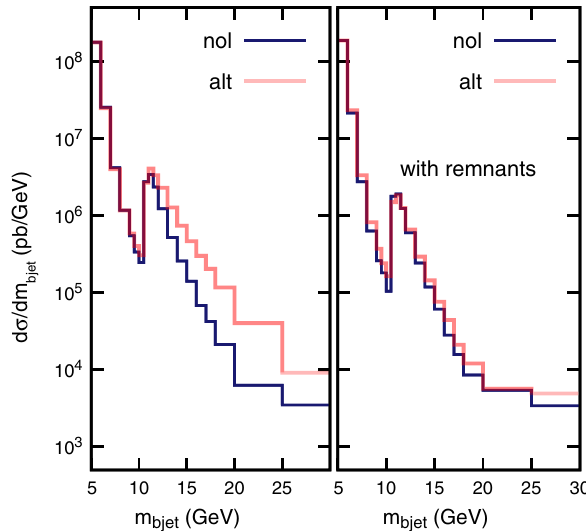
Fig. 13 Same as in Fig. 11 for the b -jet